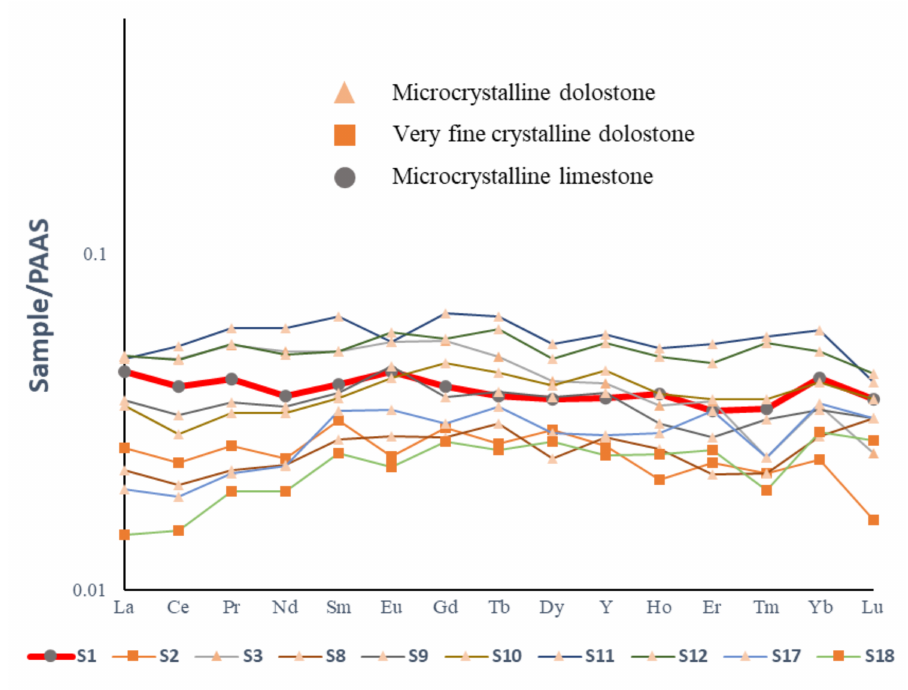
Figure 5. Distribution patterns of rare earth elements of carbonate in M 55 in the Daniudi Gas Field, Ordos Basin. Table 5. Rare earth elements compositions of the M 55 from the Daniudi Gas Field in the Ordos